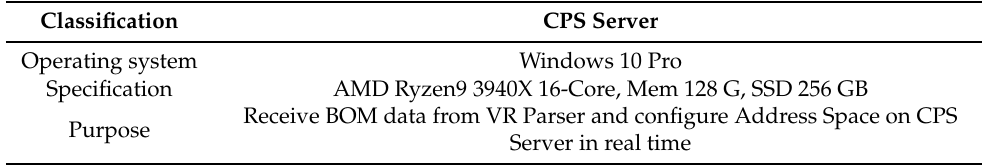
Table 1. Implementation of CPS Server.